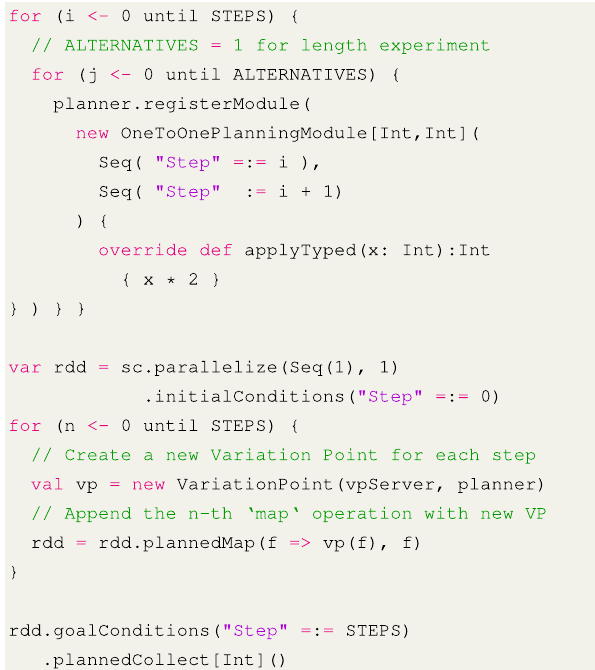
Listing 1. Overview of the generator for variable length pipelines.